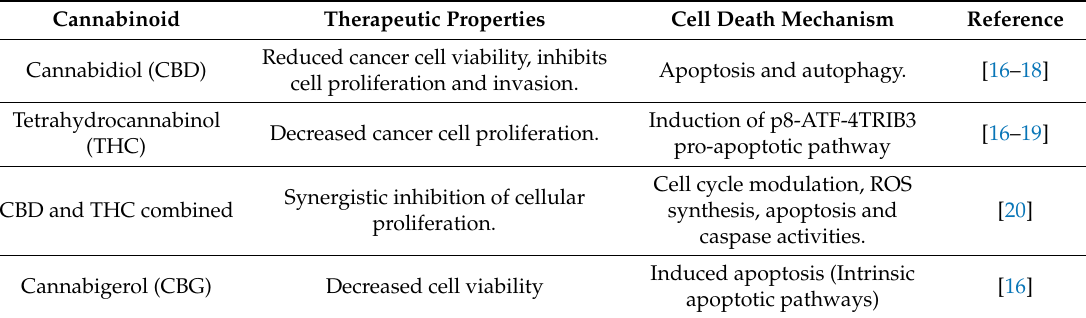
Table 1. Antitumour properties of some of the Cannabis